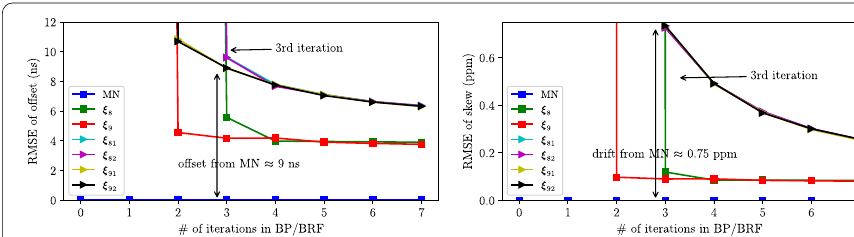
Fig. 10 BP and BRF applied to the network in a hybrid